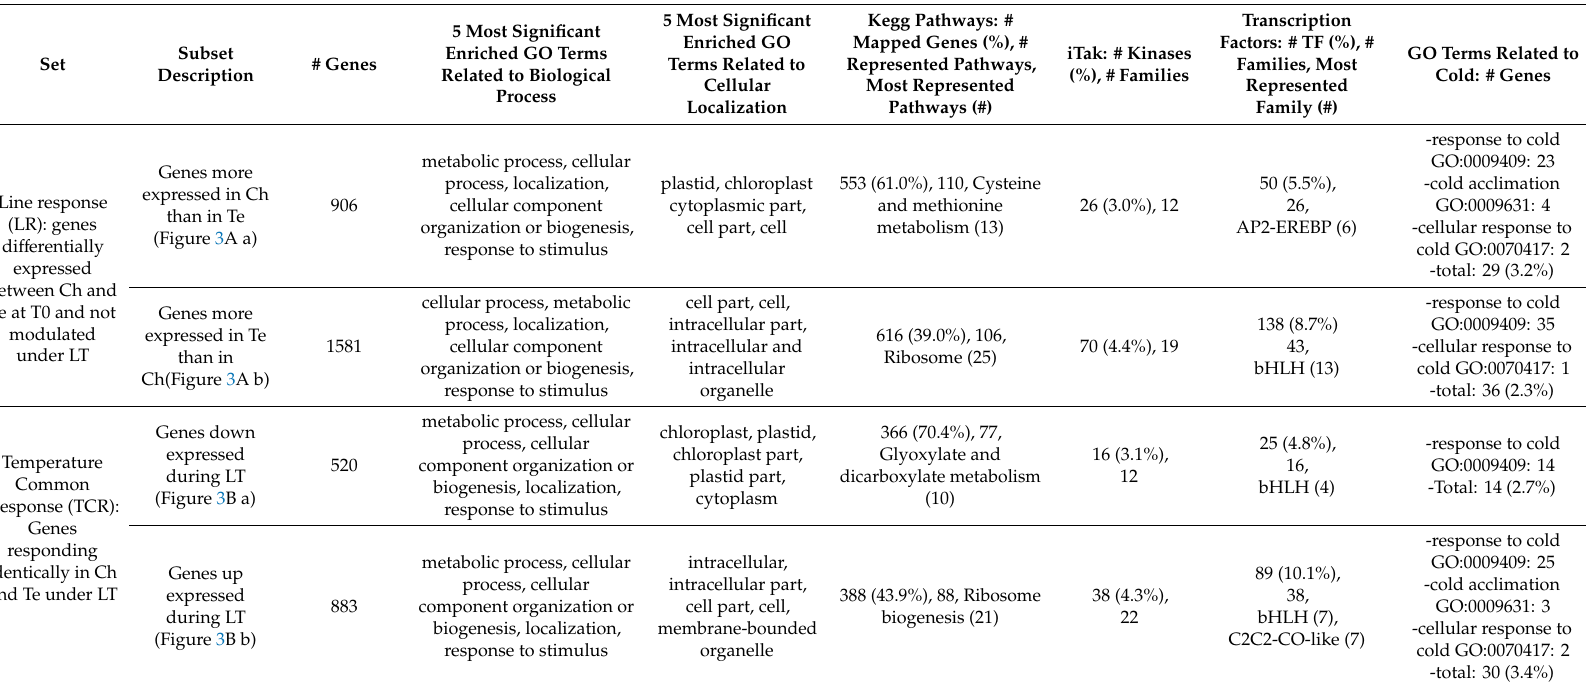
Table 1. Summary of the functional